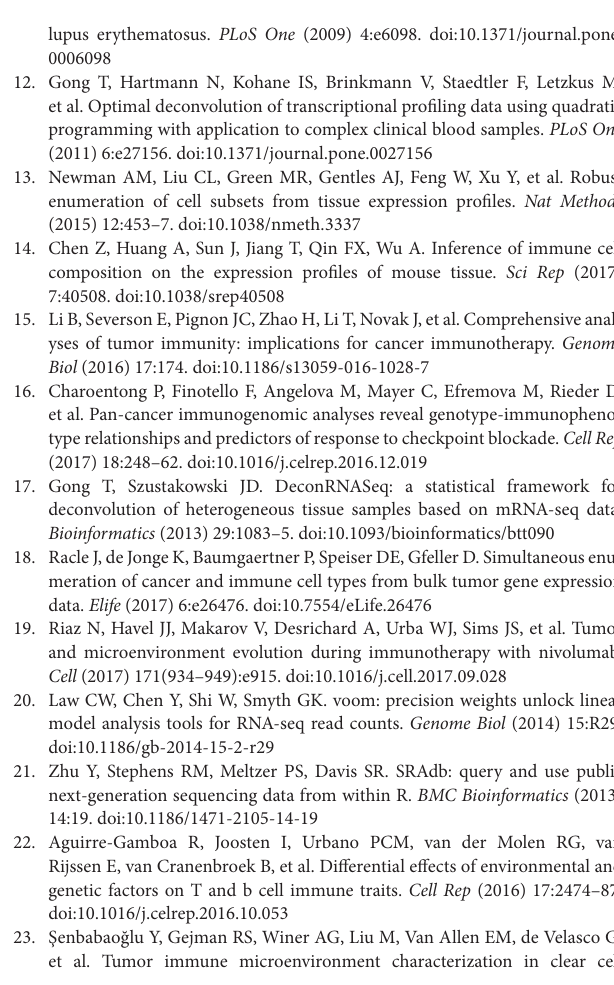
FIGURe s1 | Schematic of the ImmuCC model construction. FIGURe s2 | PCA of 162 selected genes in 286 enriched immune cell data. FIGURe s3 | Comparison of the RNA-Seq training and testing models with the flow cytometry for Granulo-monocytic cells, CD4 T cells, CD8 T cells, and B cells in the bone marrow, lymph nodes, and spleen. FIGURe s4 | Boxplot of IgA expression in 27 mouse tissues. FIGURe s5 | Heatmap for the expression profile of B cell-specific genes in the fetal liver and the adult liver. FIGURe s6 | Inferred proportions of 10 immune cells in 26 mouse tissues. FIGURe s7 | Distribution of CD4 T cells, CD8 T cells, macrophages, monocytes, neutrophils, mast cells, eosinophils, dendritic cells and natural killer cells proportion across 27 mouse tissues. FIGURe s8 | Inferred proportions of 10 immune cells in 17 mouse tumor tissues. FIGURe s9 | Distribution of CD4 T cells, CD8 T cells, macrophages, monocytes, neutrophils, mast cells, eosinophils, dendritic cells and natural killer cells proportion across 18 mouse tumor